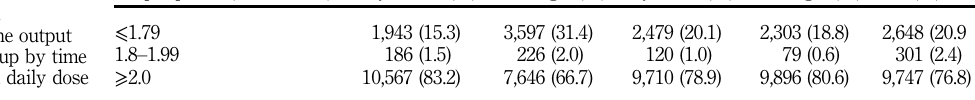
Table III. Smartphone output power group by time cycles and daily